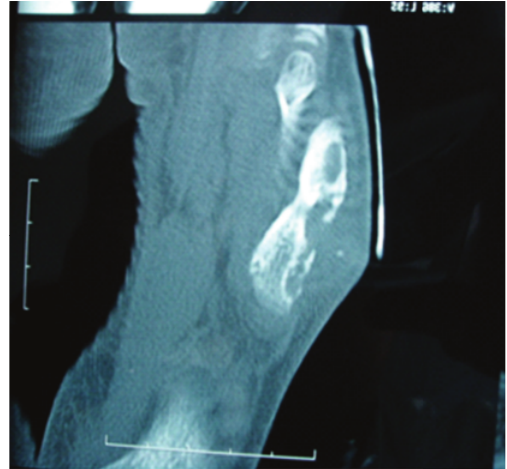
Figure 2: CT showed geodes with reactive sclerosis and soft tissue swelling without